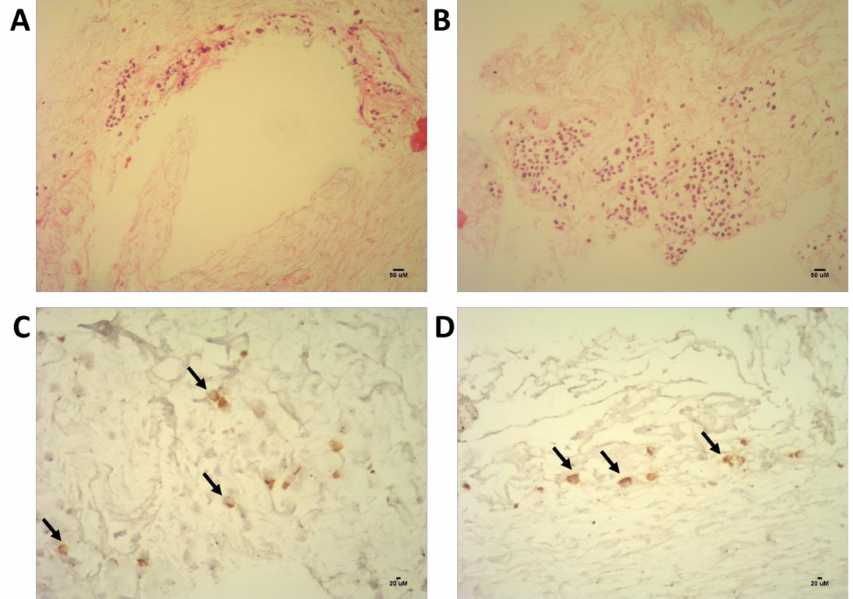
Figure 4. Non-hematopoietic niche cells (CD34 − cells) from a human donor adhered to specific regions of the bone marrow niche model and proliferated in the decellularized scaffold (panels A , B ). Lower panels ( C , D ) showed the CD90 + cells (marker of mesenchymal cells). The images are part of recent characterization of the decellularized bone marrow (DeBM) and have not been published